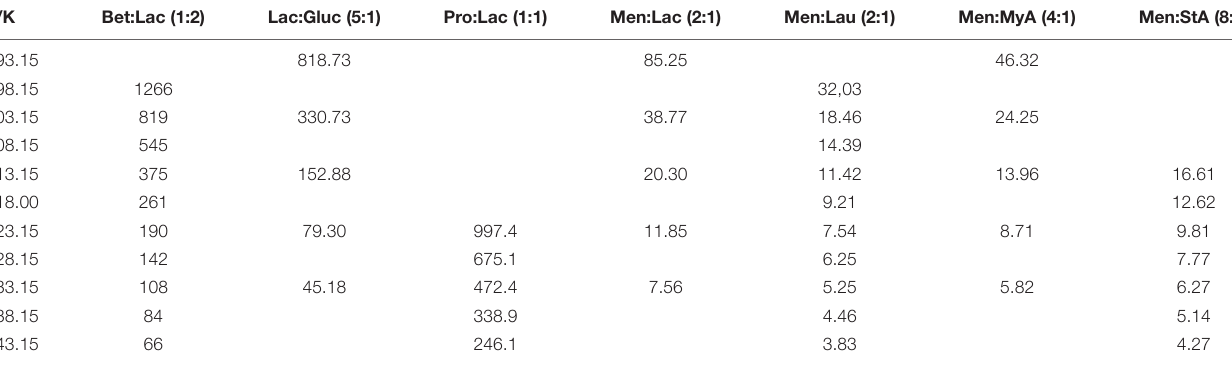
TABLE 4 | Experimental viscosities, η , expressed in mPA/s, of the DESs:Betaine lactic acid Bet:Lac (1:2), lactic acid glucose Lac:Gluc (5:1), proline lactic acid Pro:Lac (1:1), menthol lactic acid Men:Lac (2:1), menthol lauric acid (2:1), menthol myristic acid Men:MyA (4:1).